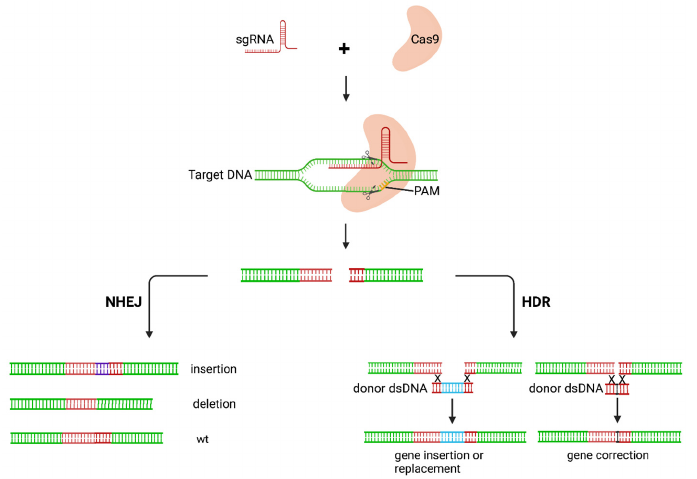
Figure 3. Mechanism of action of CRISPR-Cas9 gene editing. The CRISPR-Cas9 complex cleaves the target and creates a DSB. The DSB is then repaired via either the NHEJ or HDR pathway. The NHEJ pathway is error-prone, resulting in loss of gene function caused by indels in gene sequence. HDR results in precise modifications of the target. sgRNA, single guide RNA; PAM, protospacer-adjacent motif; NHEJ, nonhomologous end-joining; HDR, homology-directed repair; wt, wildtype. Created with BioRender.com.